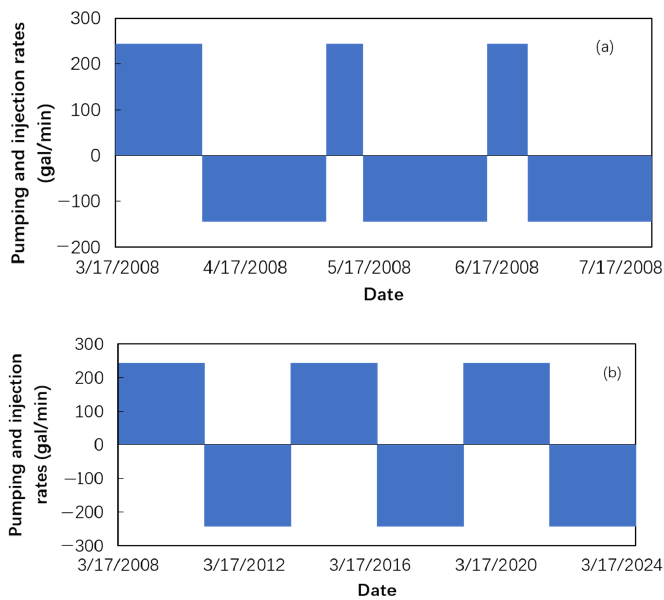
Figure 3. Pumping and injection rates employed for particle tracking over ( a ) 130 days and ( b ) 6000 days under continuous pumping and injection conditions at the Meadows Pumping Center, CO, USA.